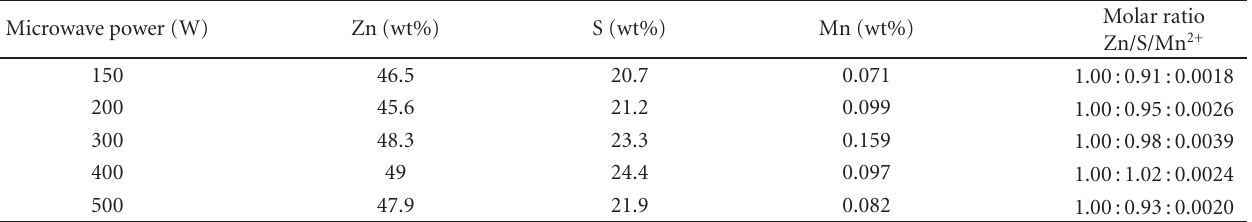
Table 2: Compositions of ZnS:Mn 2+ nanoparticles prepared at di ff erent power level measured by inductively coupled plasma atomic emission